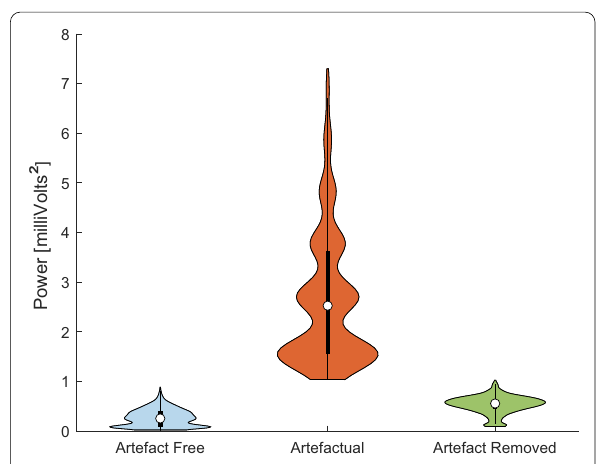
Fig. 7 Violin Plot of power in the normal (blue) 1 s segments, artefactual segments before (red) and after (green) processing from data set 1. The method has reduced the power of the artefactual segments to similar values to the artefact-free segments